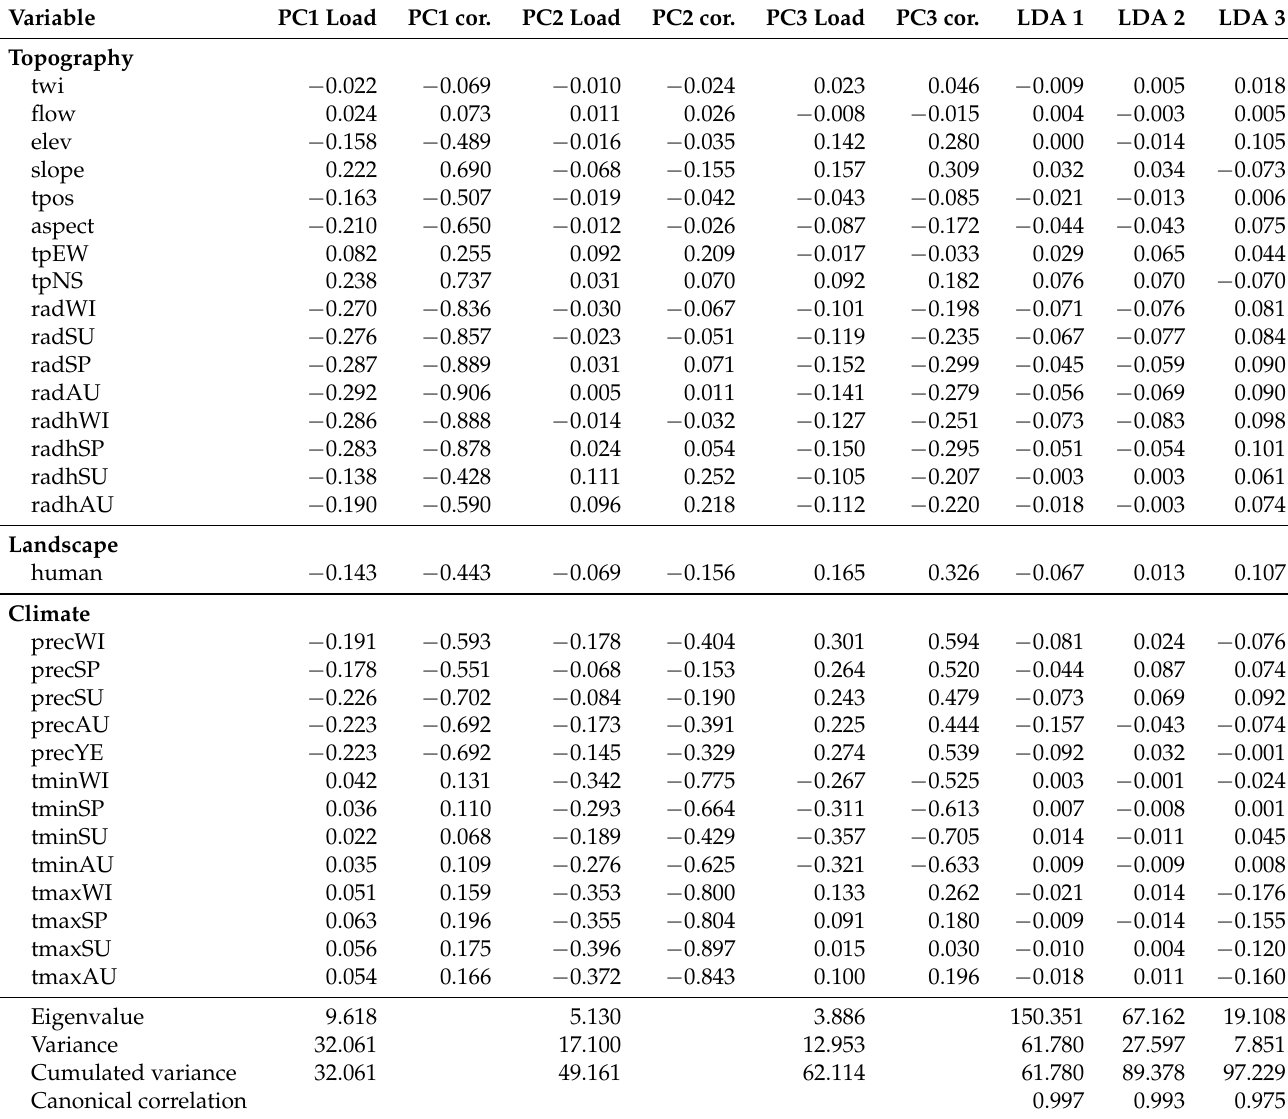
Table 3. Results of the principal component and discriminant analysis. The first three axes for PCA and LDA are shown. Loadings and correlations of the environmental variables on the principal component axis are reported. For LDA, canonical correlations of environmental variables with each discriminant function are